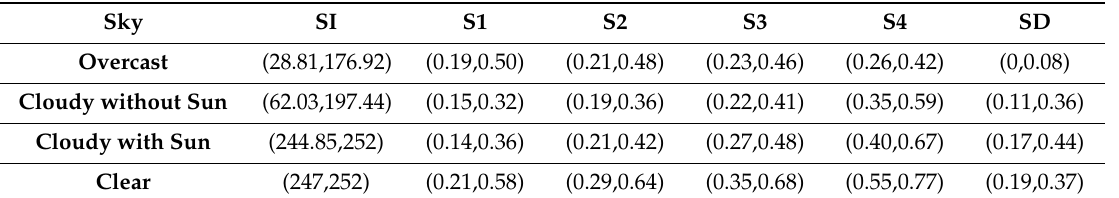
Table 3. Statistical results of SI, S of di ff erent layers, and SD for four categories of images. Sky SI